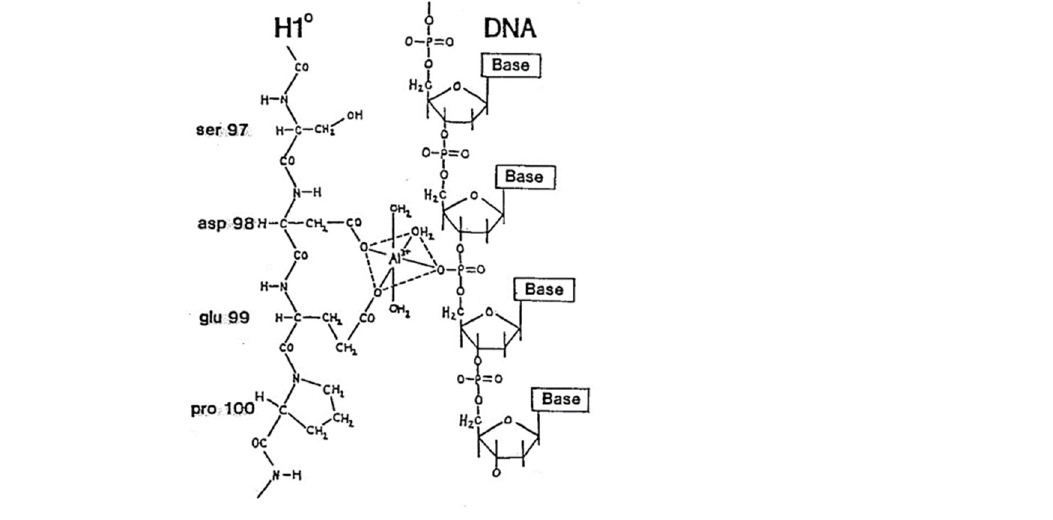
Figure 2. Al 3+ , DNA and linker histone H1 ◦ - Proposed 3-dimensional (3D) model for increased stability of H1 ◦ –DNA interaction in the presence of hydroxylated Al 3+ - hypothetical interaction of asp98 and glu-99 (D98-E99) of the ~21.4 kDa, ~194 amino acid human H1 ◦ , aluminum and